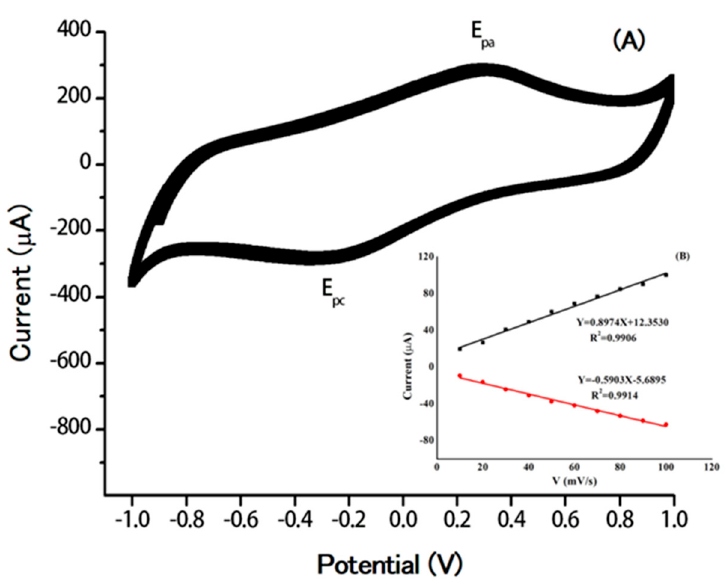
Figure 2. ( A ) Cyclic voltammogram of gold nanoparticles deposited graphene oxide modified on glassy carbon electrode (AuNPs/GO/GCE) in 0.1 M buffer (pH 7.0). Scan rate: 50 mV/s. ( B ) The plot of the anodic and cathodic peak currents vs. the scan rate.